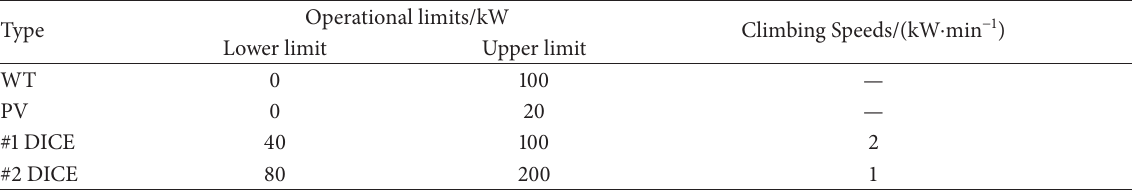
Table 2: Information of daily spot prices.